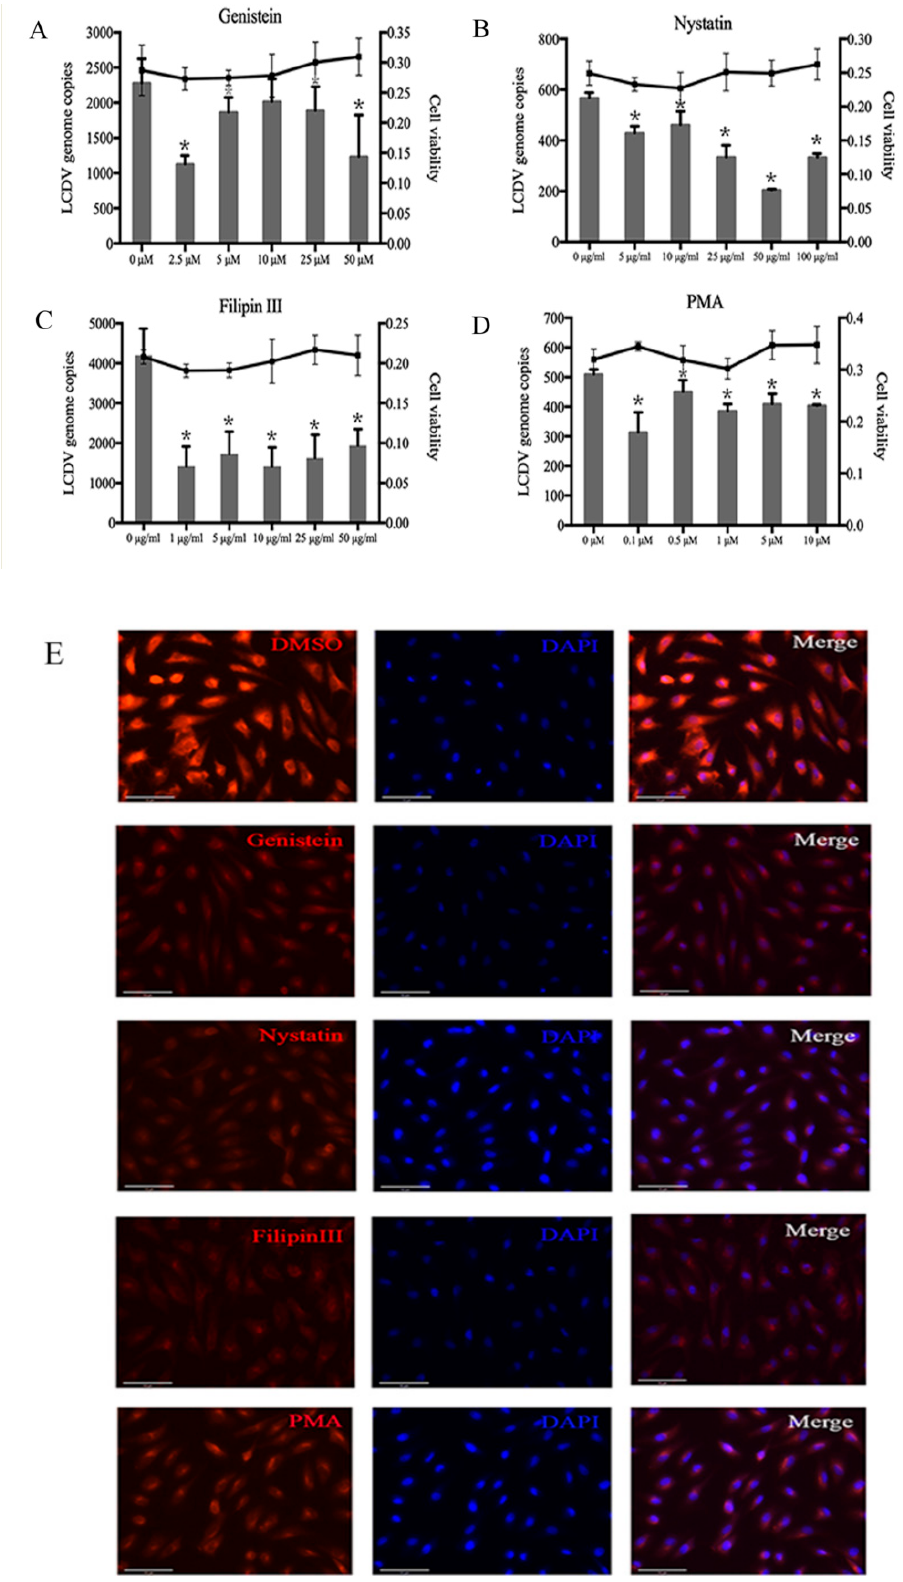
Figure 4. LCDV enters cells via caveola-dependent endocytosis. FG cells were pre-incubated with genistein ( A ), nystatin ( B ), filipin III ( C ), or PMA ( D ), and then infected with LCDV. LCDV copy numbers in FG cells were detected by qPCR; the histogram represents virus copy numbers and the line graph represents cell viability. ( E ) FG cells were treated with 10 μ M genistein, 25 μ g/mL nystatin, 10 μ g/mL filipin III, or 1 μ M